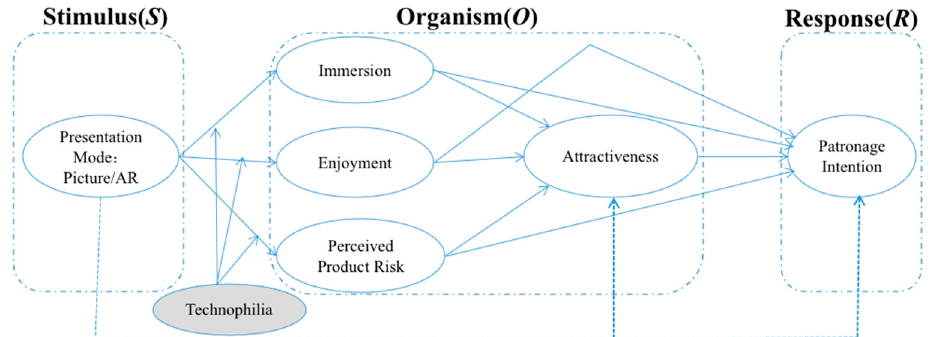
Figure 1. Research model.